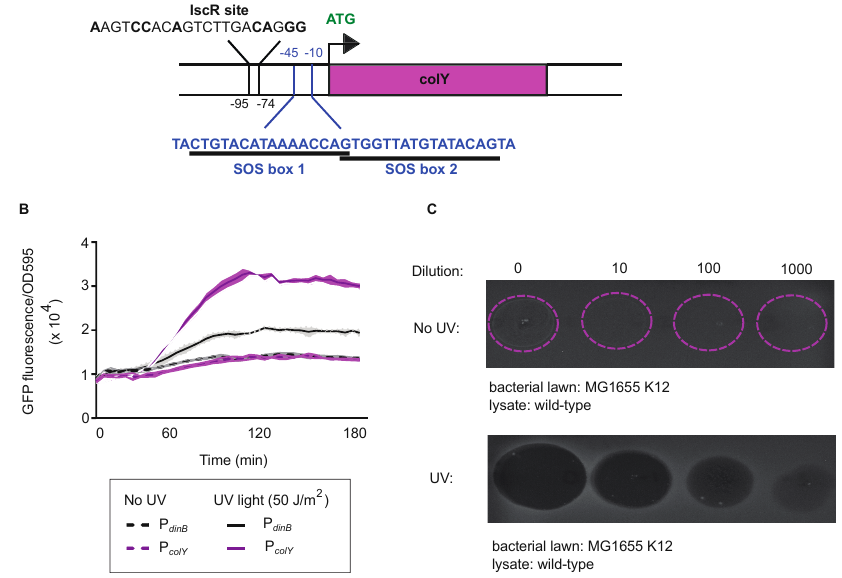
Figure 1. The MP1 colicin is SOS (bacterial DNA damage stress response pathway) regulated and active. ( A ) Sequence analysis revealed two overlapping SOS boxes and an IscR binding site upstream of the start codon. ( B ) GFP expression from the colY promoter depends upon DNA damage. The kinetics of GFP expression mirror another SOS-controlled gene, dinB. Time-dependent induction of GFP is represented as fluorescence intensity normalized to optical density at 595 nm at the start of the experiment. The error bands show the standard deviations of results from four independent biological replicates for each condition. ( C ) Shown is the inhibition halo of E. coli K12 (MG1655) by cell lysates of wild-type MP1 generated either with or without UV exposure. Dilutions of cell lysates were made and indicated. Dashed circles indicate location of spotted lysate.